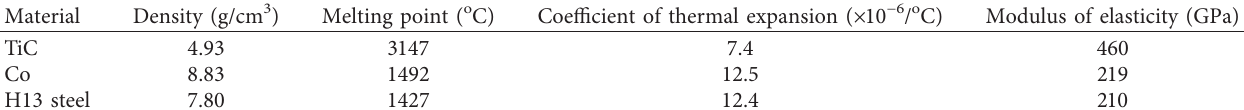
Table 7: Material properties of TiC, Co, and H13 steel.